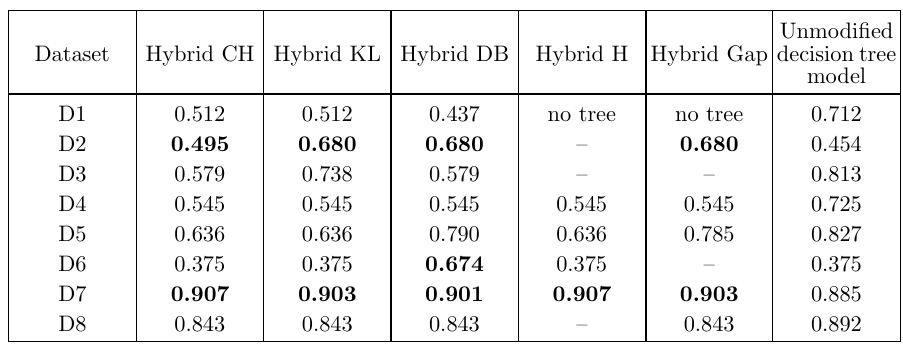
Values of recall Dataset Hybrid CH Hybrid KL Hybrid DB Hybrid H Hybrid Gap decision tree